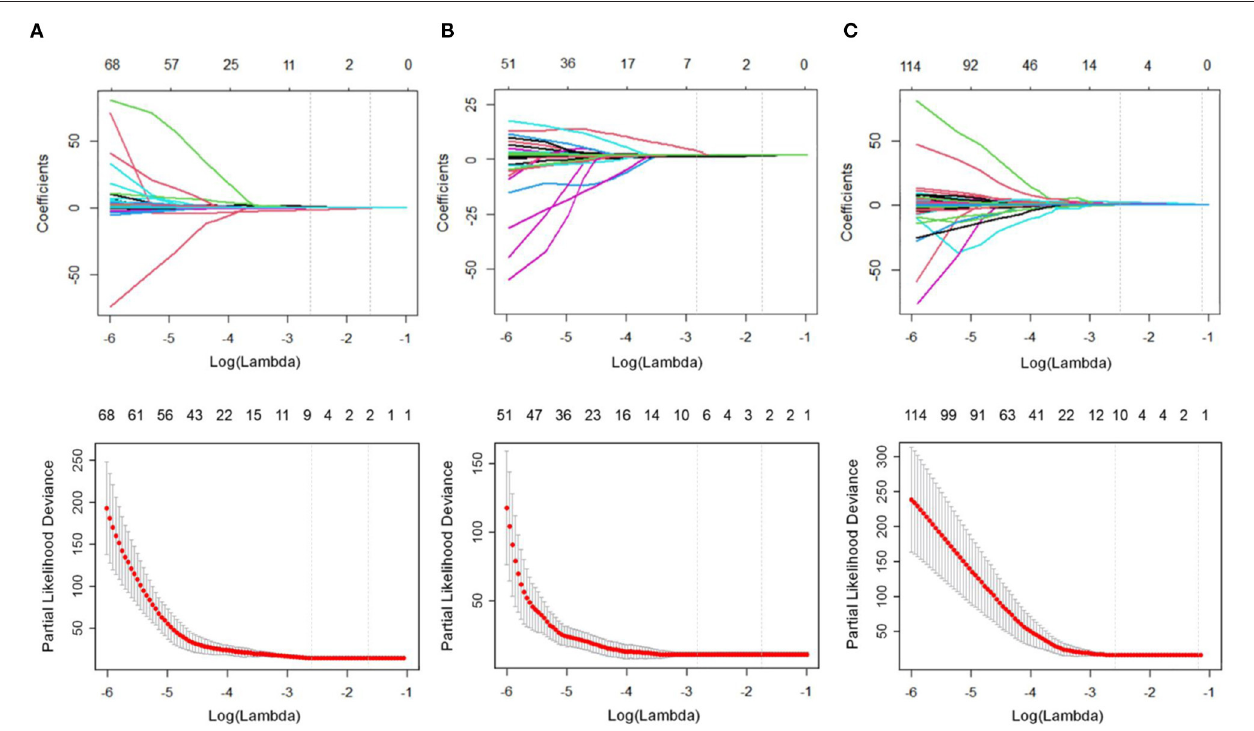
FIGURE 3 | Feature selection using the least absolute shrinkage and selection operator (LASSO) Cox regression model. The partial likelihood deviance was plotted vs. log ( λ ). The tuning parameter ( λ ) was chosen in the LASSO Cox model via the minimum criteria. Dotted vertical lines were drawn at both the optimal and minimum values from left to right by using the minimum criteria and 1 standard error of the minimum criteria. (A) In the liver group, we examined the coefficients of the 953 radiomics features to identify 7 potential predictors. A λ -value of 0.0714, with log ( λ ), − 2.6391, was chosen using 10-fold cross-validation. (B) In the spleen group, we examined the coefficients of the 929 radiomics features to identify 6 potential predictors. A λ -value of 0.0554, with log ( λ ) − 2.8915, was chosen. (C) In the combined liver and spleen group, we examined the coefficients of the 1882 radiomics features to identify 10 potential predictors. A λ -value of 0.0675, with log ( λ ) − 2.6956, was